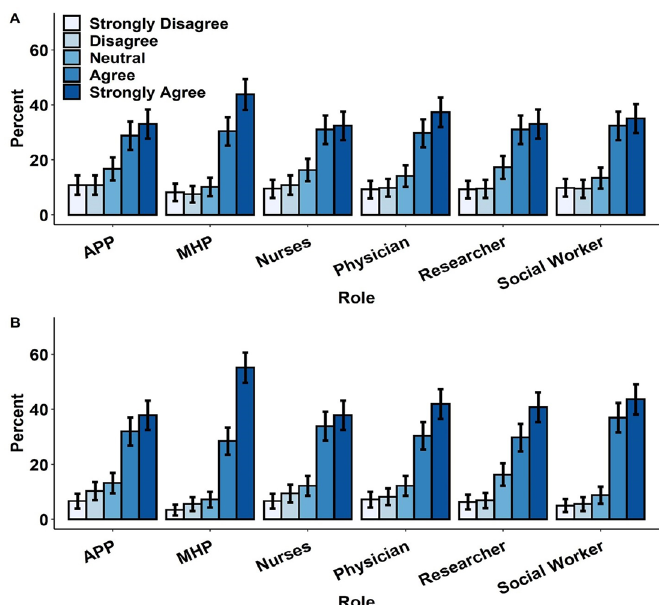
Figure 1. Patient degree of agreement that discussing with each provider type is appropriate in A (patients with gun access) and B (patients without gun access). Error bars represent 95% confidence